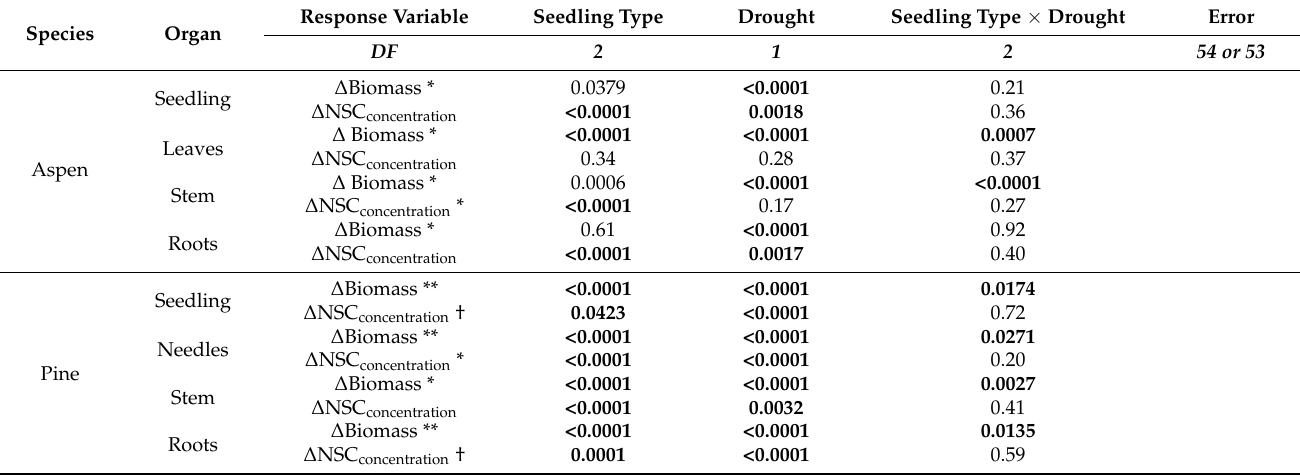
Table 1. Summary of analysis of variance for change in structural biomass (i.e., structural growth ( ∆ Biomass) and change in NSC concentrations ( ∆ NSC concentration ) of aspen and pine seedlings by seedling type and drought. Significant effects ( p ≤ 0.10) are indicated in bold, n = 10 per seedling type/drought treatment combination, except where